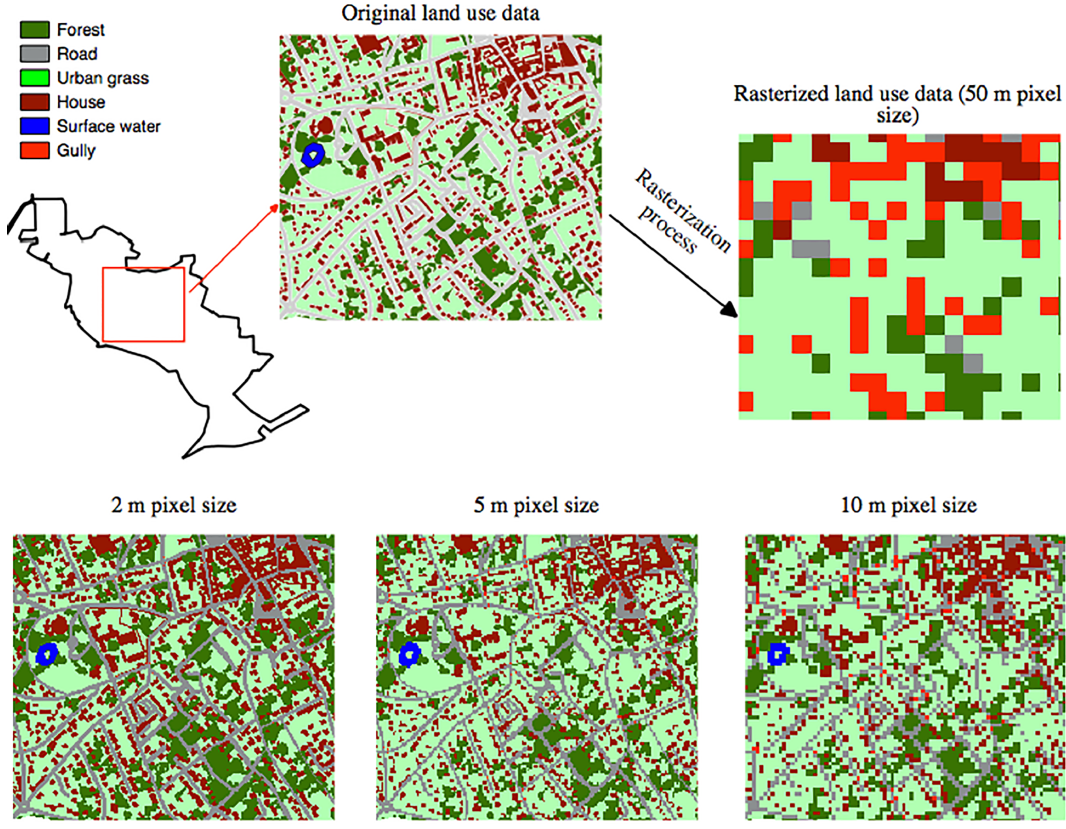
Figure 8. Scale effect observed on the catchment land cover. The grid size strongly affects the way land cover heterogeneity is represented in the